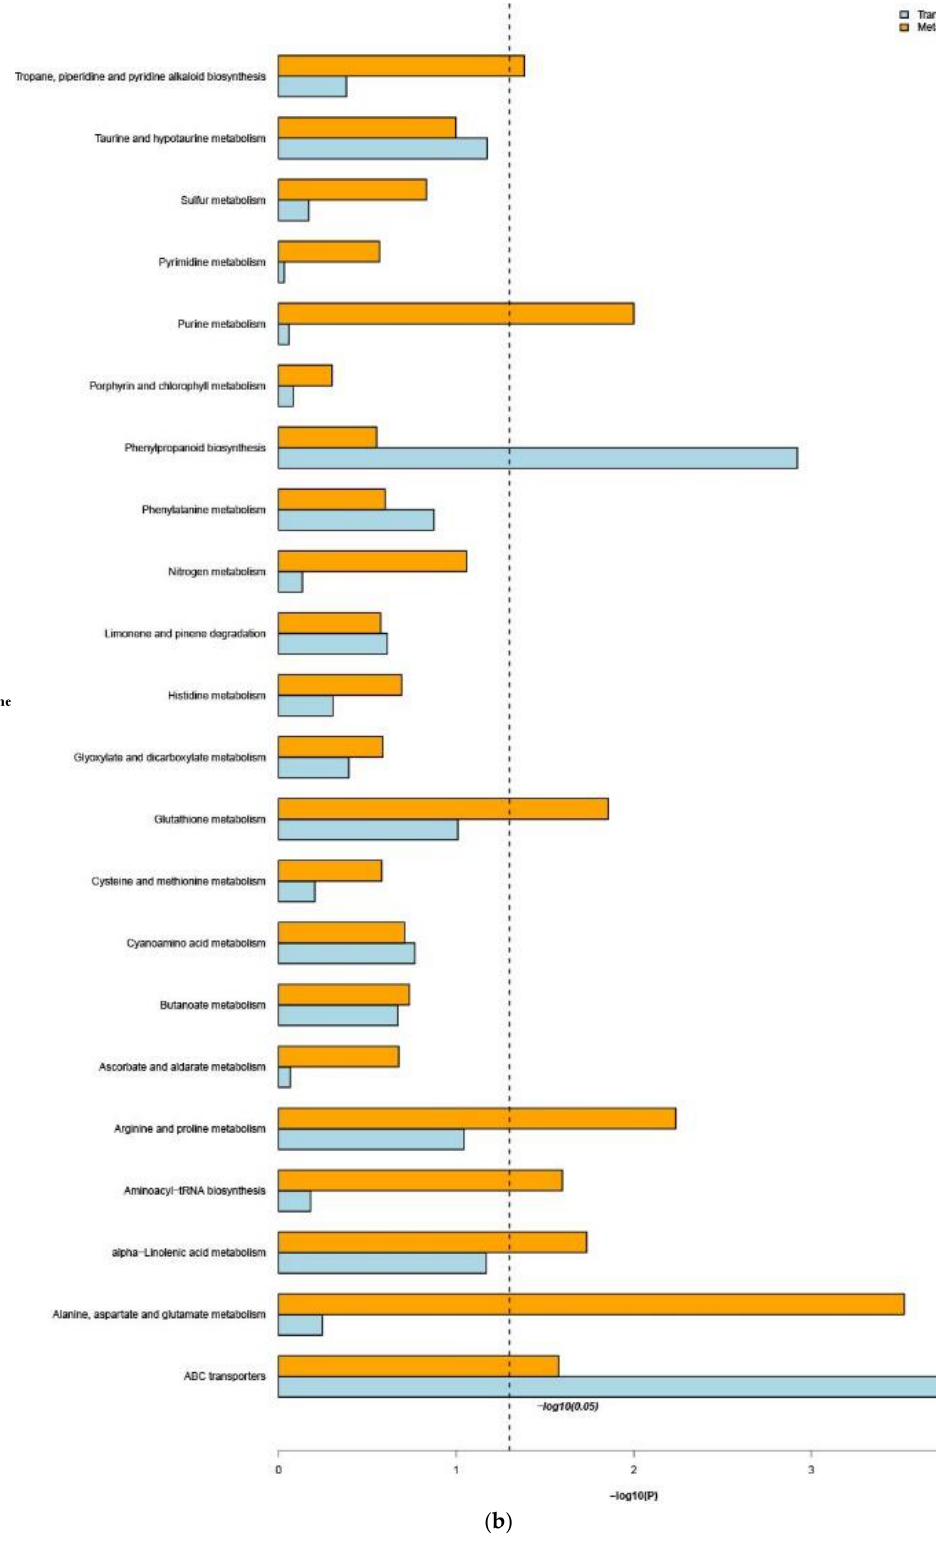
Figure 14. ( a ) Venn diagrams of DEGs and differentially accumulated metabolites. ( b ) KEGG enrichment pathways.